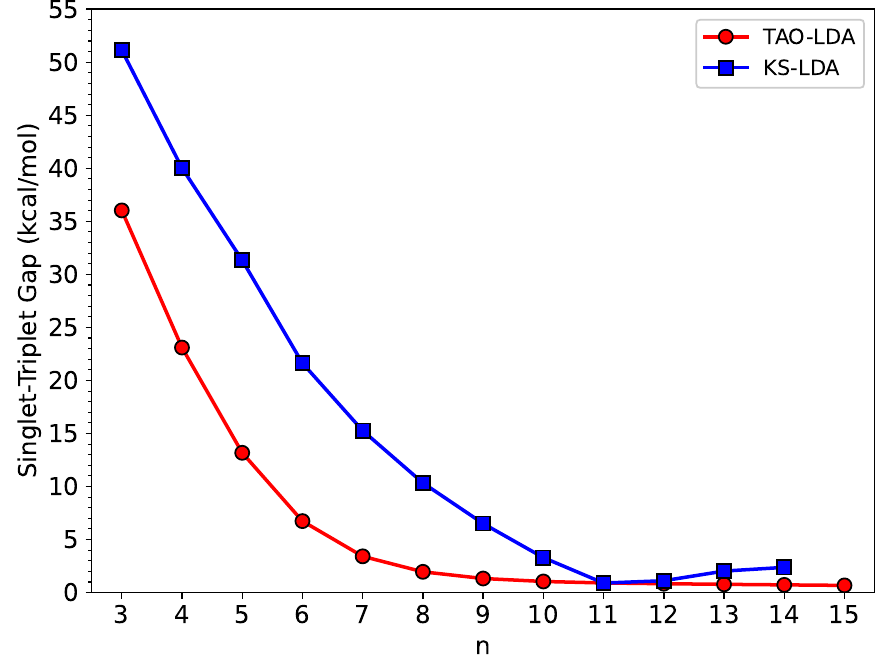
Figure 2. Singlet–triplet gap of n -HGQR calculated by spin-unrestricted KS-LDA and TAO-LDA. To explore the possible reasons for discrepancies, we reveal the expectation values of the total spin-squared operator (cid:104) ˆ S 2 (cid:105) associated with the lowest singlet and lowest triplet states of n -HGQR, computed using spin-unrestricted KS-LDA (see Table 1). If the KS- LDA wavefunction has spin contamination (which is the artificial mixing of different spin-states) [68,71,79], the corresponding (cid:104) ˆ S 2 (cid:105) value will be larger than the exact (cid:104) ˆ S 2 (cid:105) value (i.e., 0 for the lowest singlet state and 2 for the lowest triplet state; e.q., refer to Section I in the SI of Ref. [79]). Consequently, the difference between the (cid:104) ˆ S 2 (cid:105) value of KS-LDA and the exact (cid:104) ˆ S 2 (cid:105) value is commonly used to assess the degree of spin contamination KS-LDA are rather close to the exact (cid:104) ˆ S 2 (cid:105) values, indicating that the lowest singlet and lowest triplet states of n -HGQR, obtained with spin-unrestricted KS-LDA, essentially